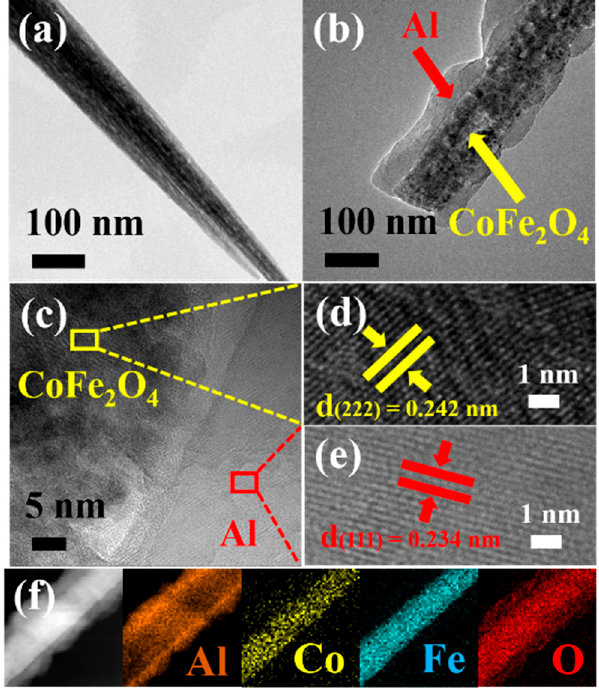
Figure 4. The transmission electron microscopy (TEM) images of the ( a ) CoFe 2 O 4 NWs, ( b ) CoFe 2 O 4 / Al NWs (Al = 200 nm), ( c , d , e ) high resolution transmission electron microscopy (HRTEM) images of CoFe 2 O 4 / Al NWs (Al = 200 nm), and ( f ) the corresponding element mappings of CoFe 2 O 4 / Al NWs.